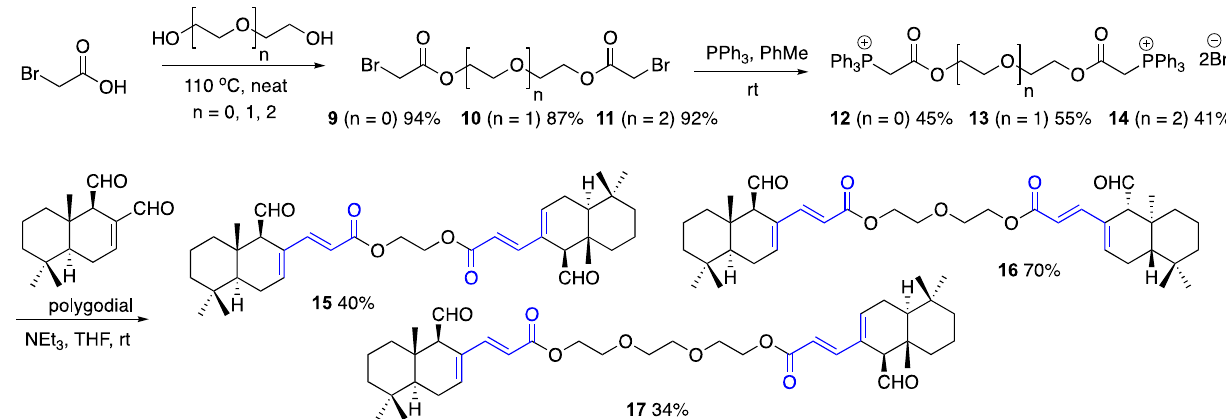
Figure 3. Synthesis of dimeric polygodial-based crosslinking agents 15 , 16 and 17.